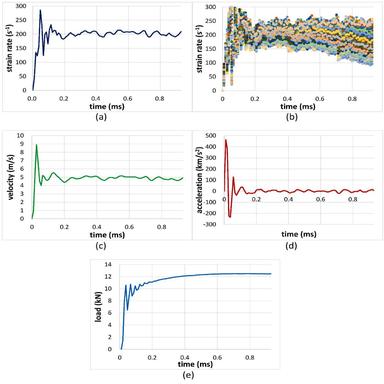
Evolution of (a) AOI-averaged strain rate (b) strain rate distribution (c) AOI-averaged velocity (d) AOI-averaged acceleration (e) load in the loading direction (FE simulation).